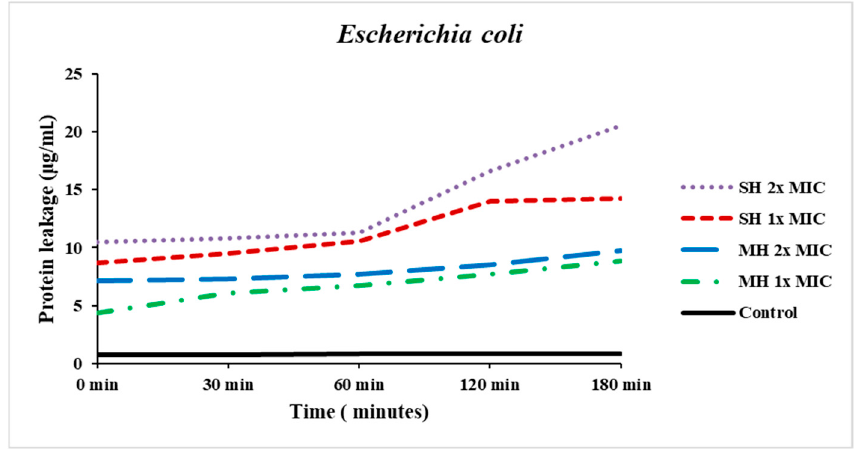
Figure 3. Effect of Sidr honey (SH) and Manuka honey (MH) at 1x MIC and 2x MIC and control on leakage from Escherichia coli .